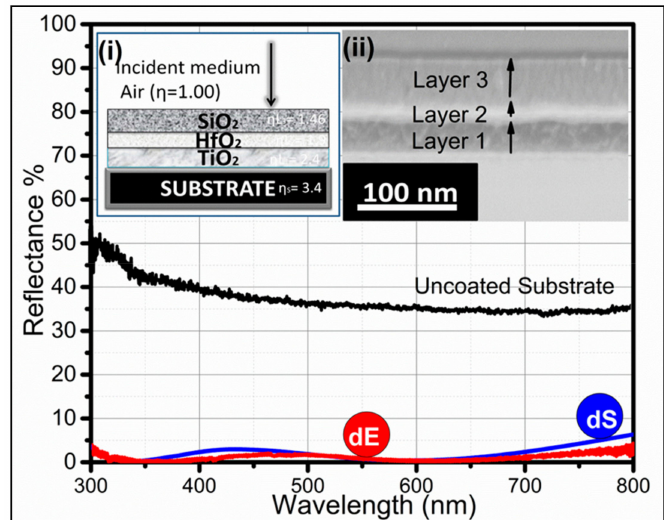
Figure 5. Simulated and measured AR e ffi ciencies of trilayer AR composite coatings. The inset demonstrates ( i ) schematic representation of the trilayer AR coating and ( ii ) cross-sectional SEM image of the fabricated AR